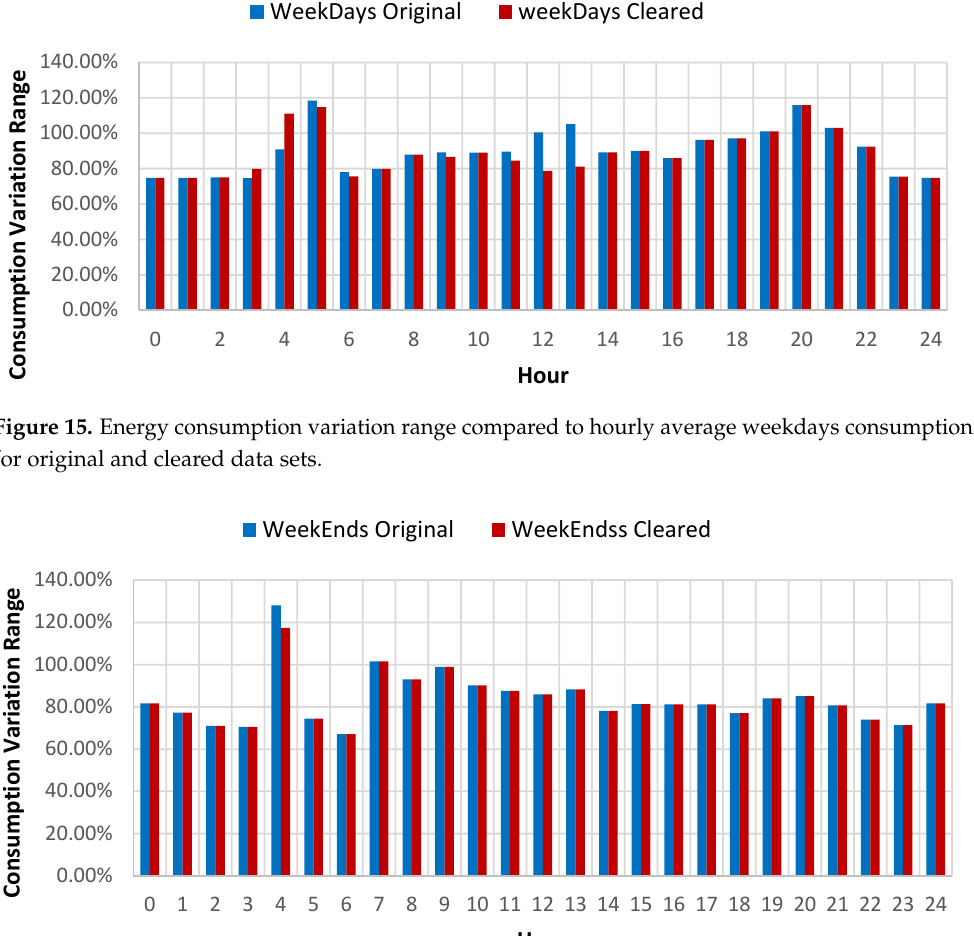
Figure 16. Energy consumption variation range compared to hourly average weekends consumption for original and cleared data sets. increased to 0.31% for weekdays, 0.27% for all the data, and 0.18% for weekends (see Table 13). For the 2nd semester, a 0.16% average SD reduction for all the days, 0.17% for weekdays and 0.13% for the weekend days was noticed (see Table 14). The daily consumption baseline for original and cleared data sets are showcased in Figure